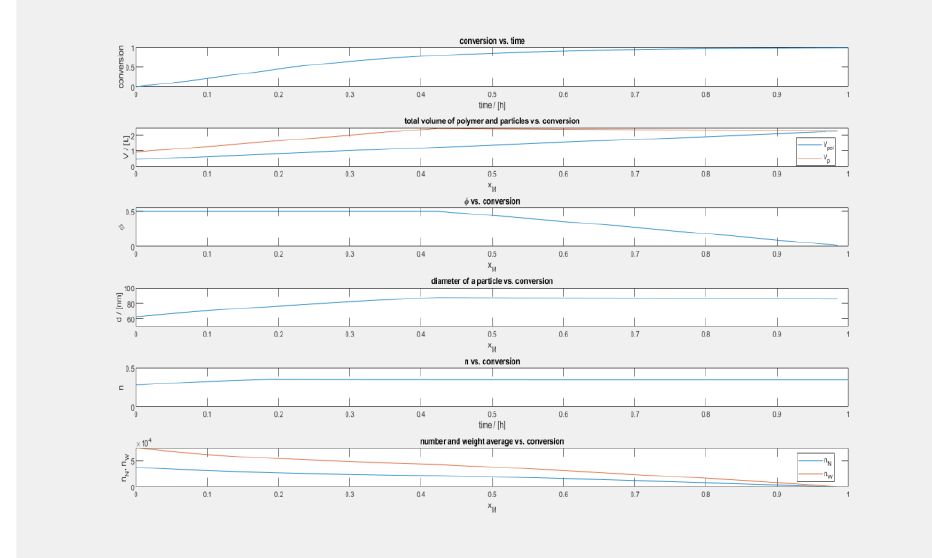
Figure 5. Variation in compressive modulus of HDPE-HA composites with HA loading.